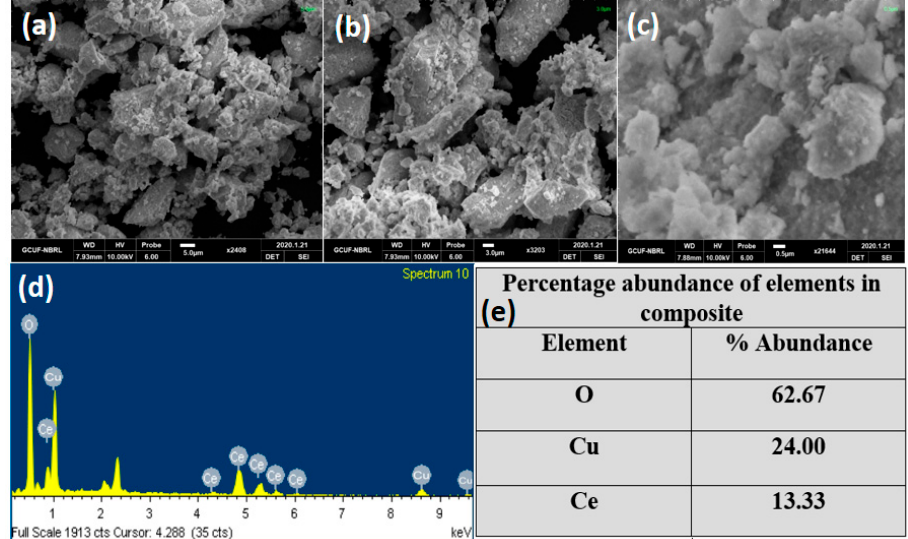
Figure 4. SEM images of CeO 2 -CuO nanocomposite ( a , b , and c ) at different magnification of ( a ) 5.0 μ m, ( b ) 3.0 μ m, and ( c ) 0.5 μ m. (d) EDS Pattern of CeO 2 -CuO nanocomposite (e)